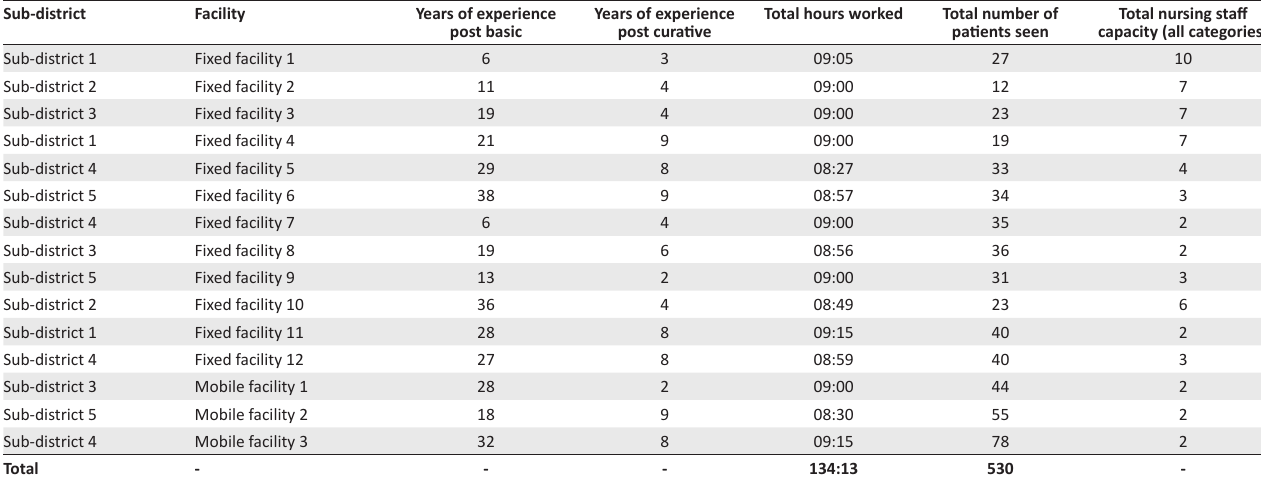
TABLE 1: Profile of observed CNPs for one day by healthcare facility.